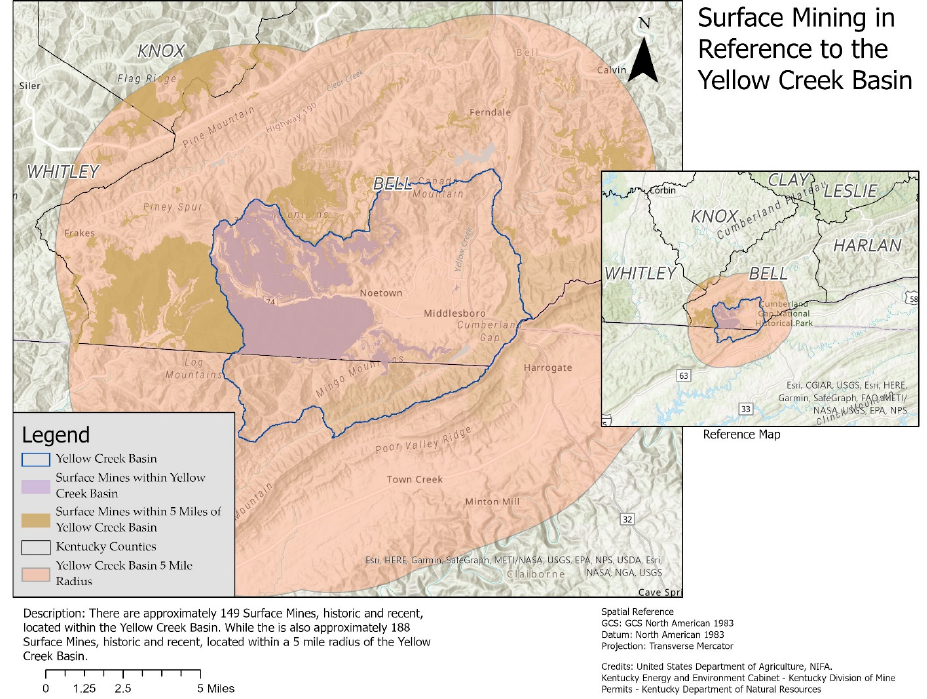
Figure A1. Coal mine areas in and outside of the watershed.